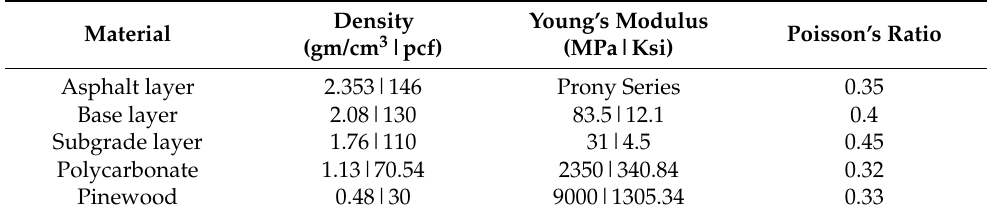
Table 4. Material characteristics for the pavement structure and the solar module components [37,41,45].